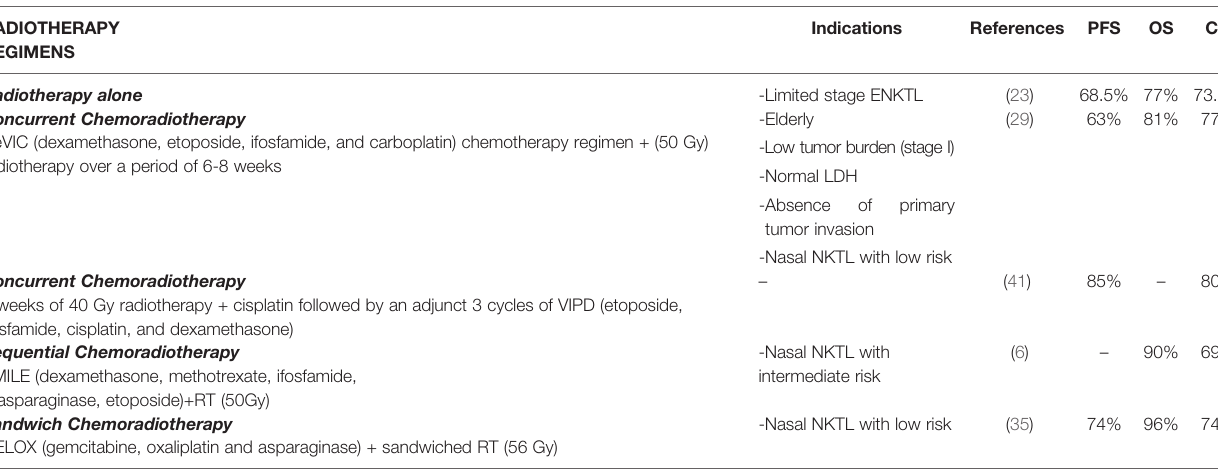
TABLE 1 | Radiotherapy in